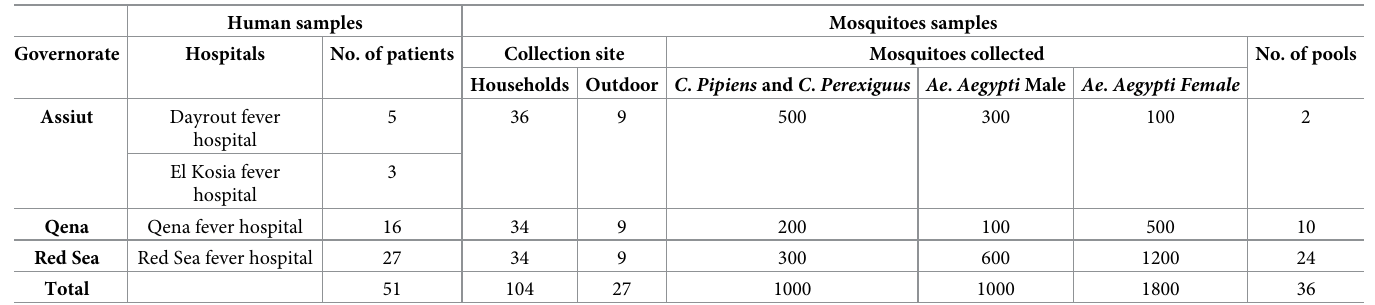
Table 1. Descriptive data on the number and sites of the recruited samples in the study. Human